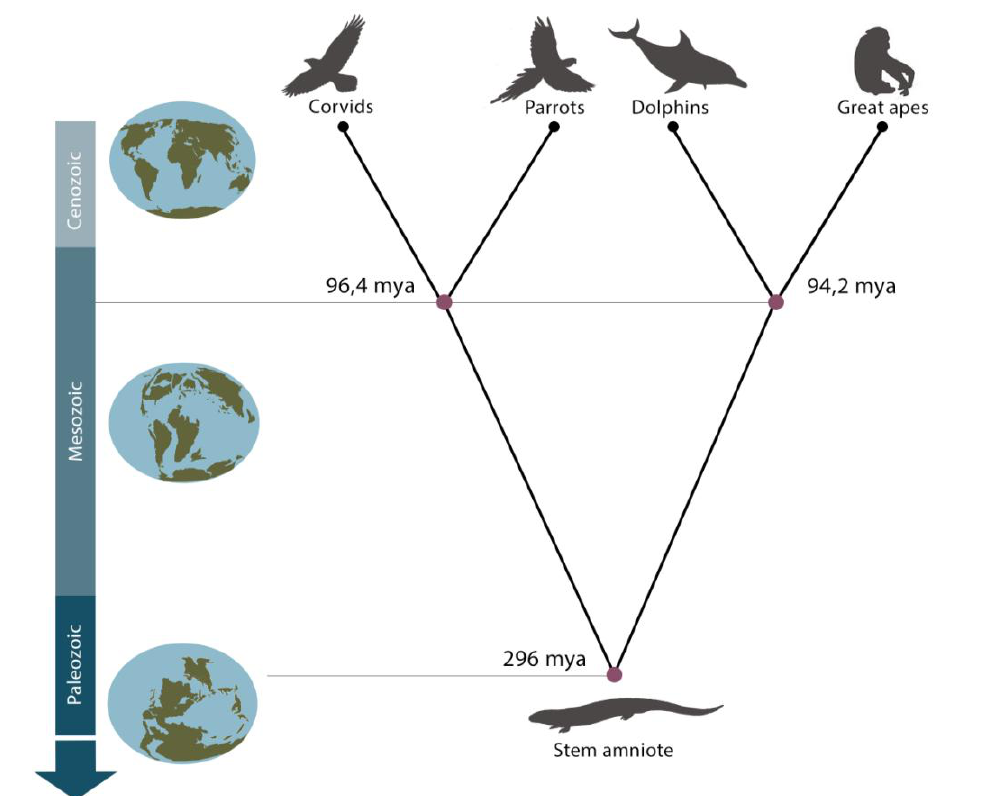
Figure 1. Evolutionary tree describing the phylogenetic distance between corvids, parrots, delphinids, and great apes. The numbers signify the distance in time of the last common ancestor of the diverging groups, as determined by the mean of the available studies as of 28 January 2014 using the web-based software Time Tree. The illustrations to left depict continental drift over the considerable geological time scale